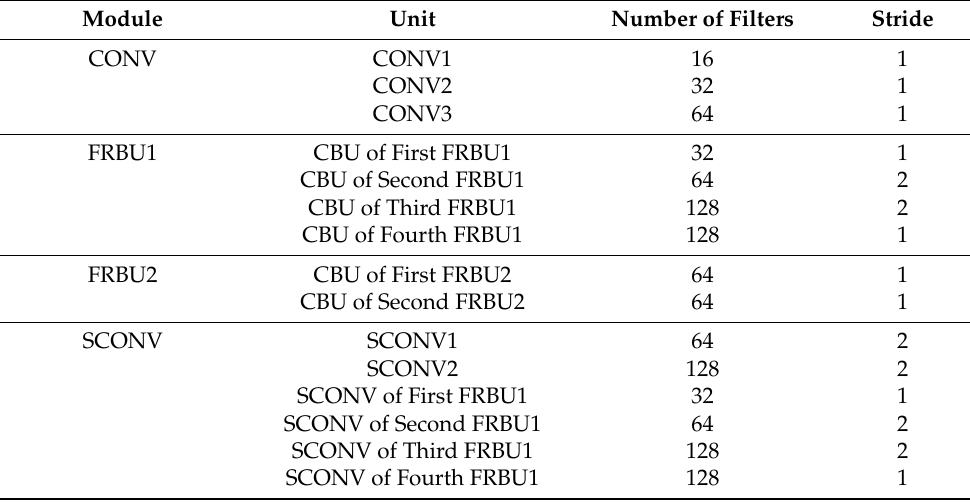
Table 1. The number of stride and filters in each